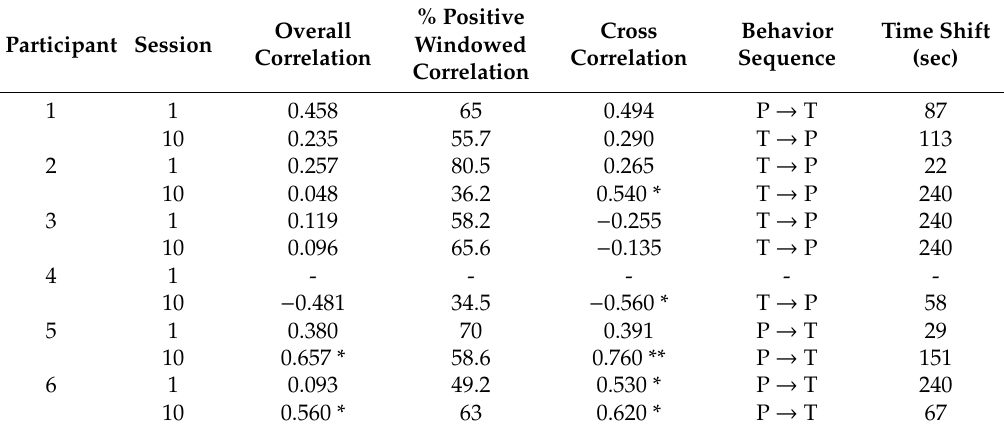
Table 5. Relations between posture and spontaneous